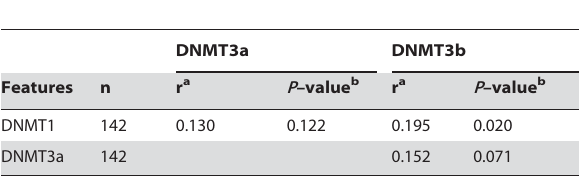
Table 3. Correlations between DNMTs expression in ovarian